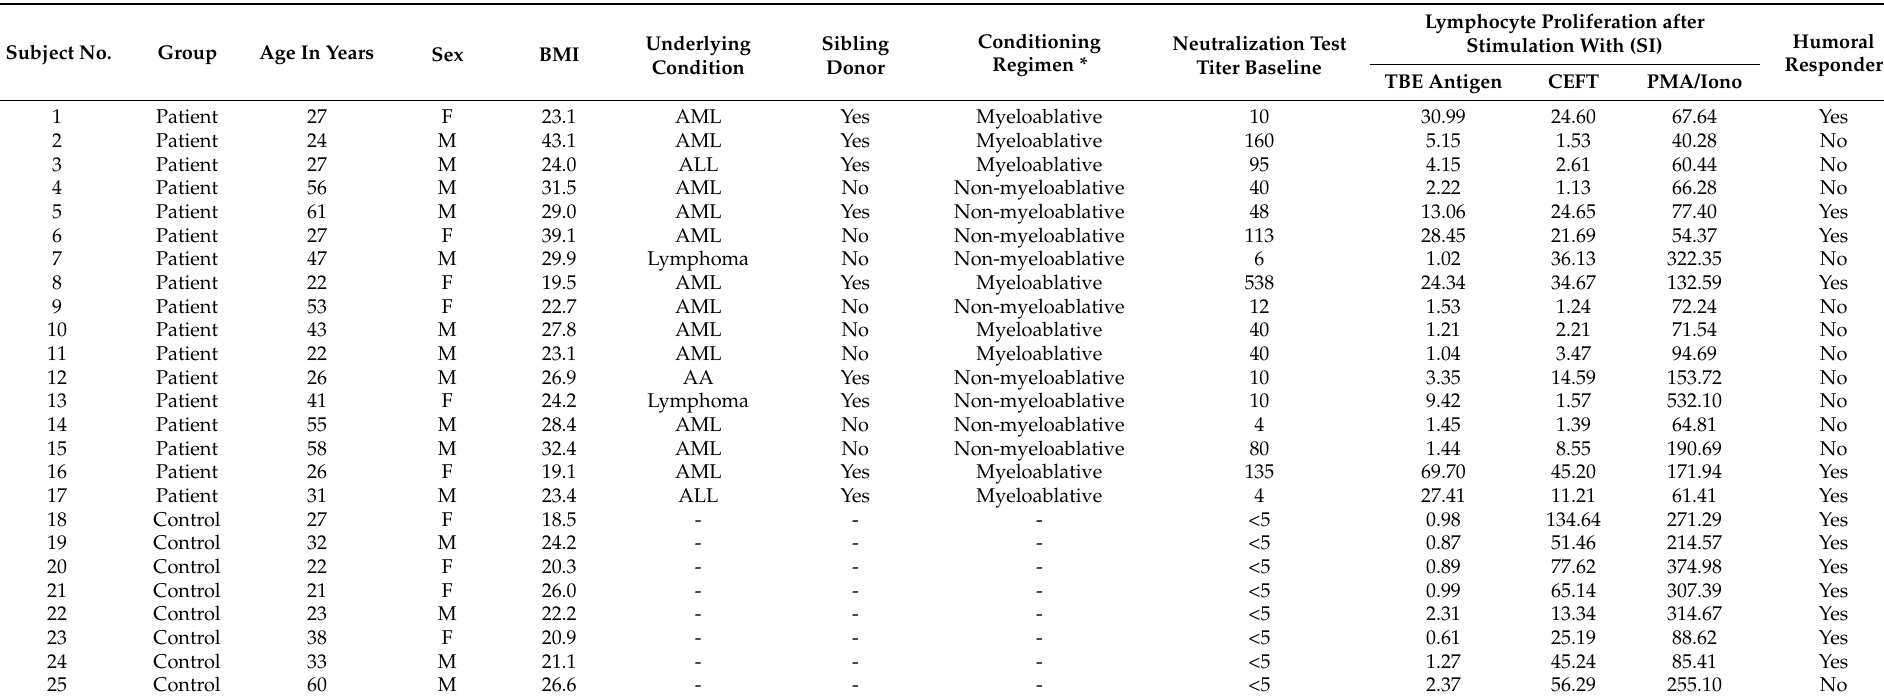
Table 1. Demographics and baseline (before vaccination, one year after HSCT) lymphocyte proliferation detected by thymidine incorporation assay (the stimulation index is given) of individual